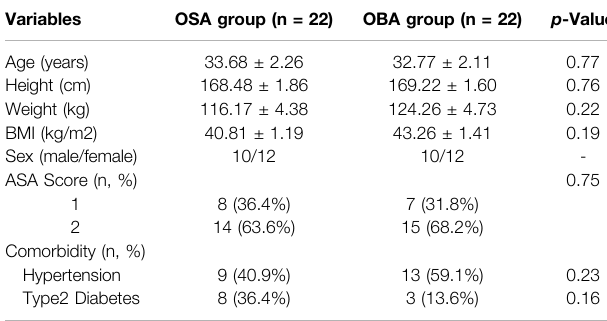
TABLE 1 | Baseline patient